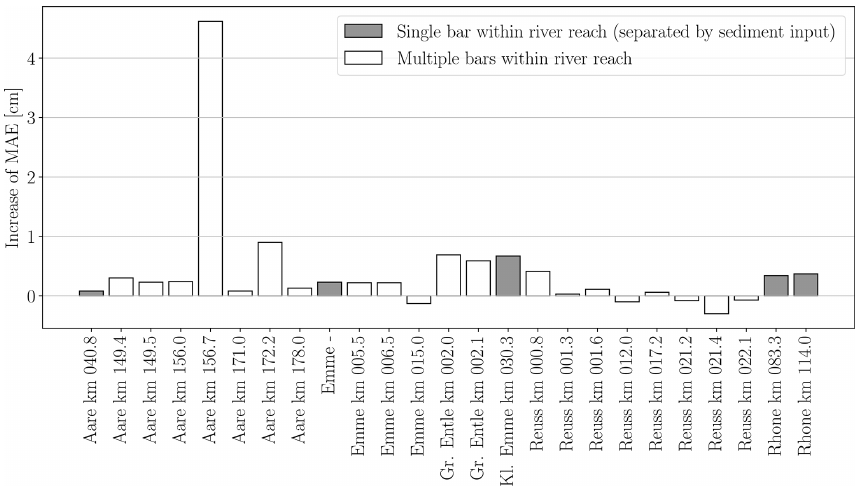
Figure G1. Generalization performance per gravel bar. Increase of mean absolute error (MAE) from the random cross-validation to the geographical generalization experiment for the GRAINet end-to-end d m regression. A positive value means that the generalization experiment has a higher error. Gravel bars on individual river reaches (i.e., separated by tributaries) are depicted in